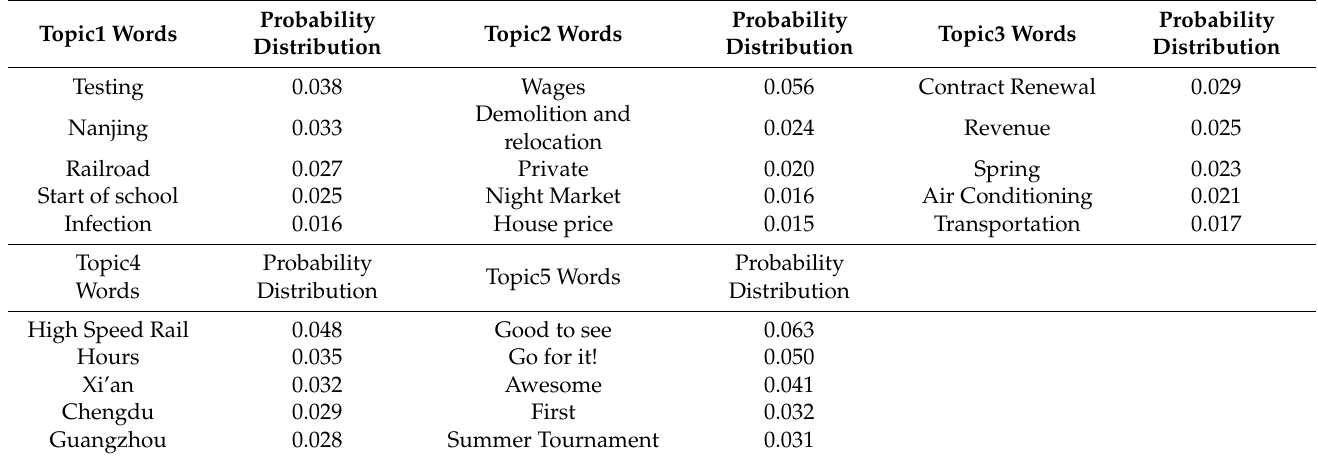
Table 10. A2 LDA theme model results.